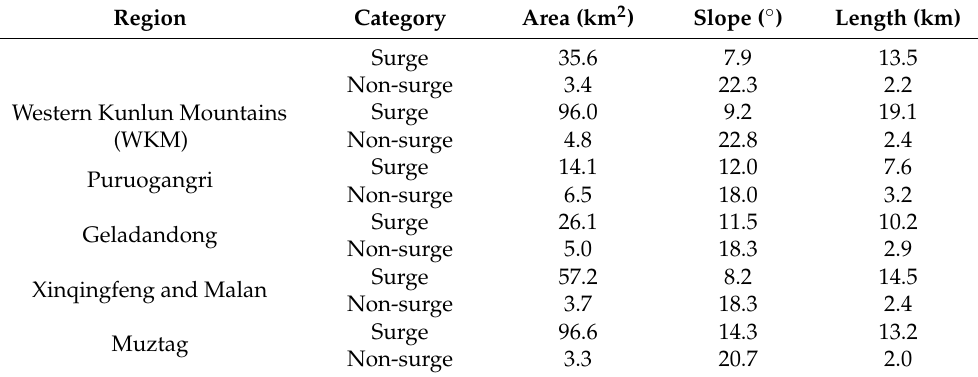
Table 2. Averaged geometric information of glaciers in six surging